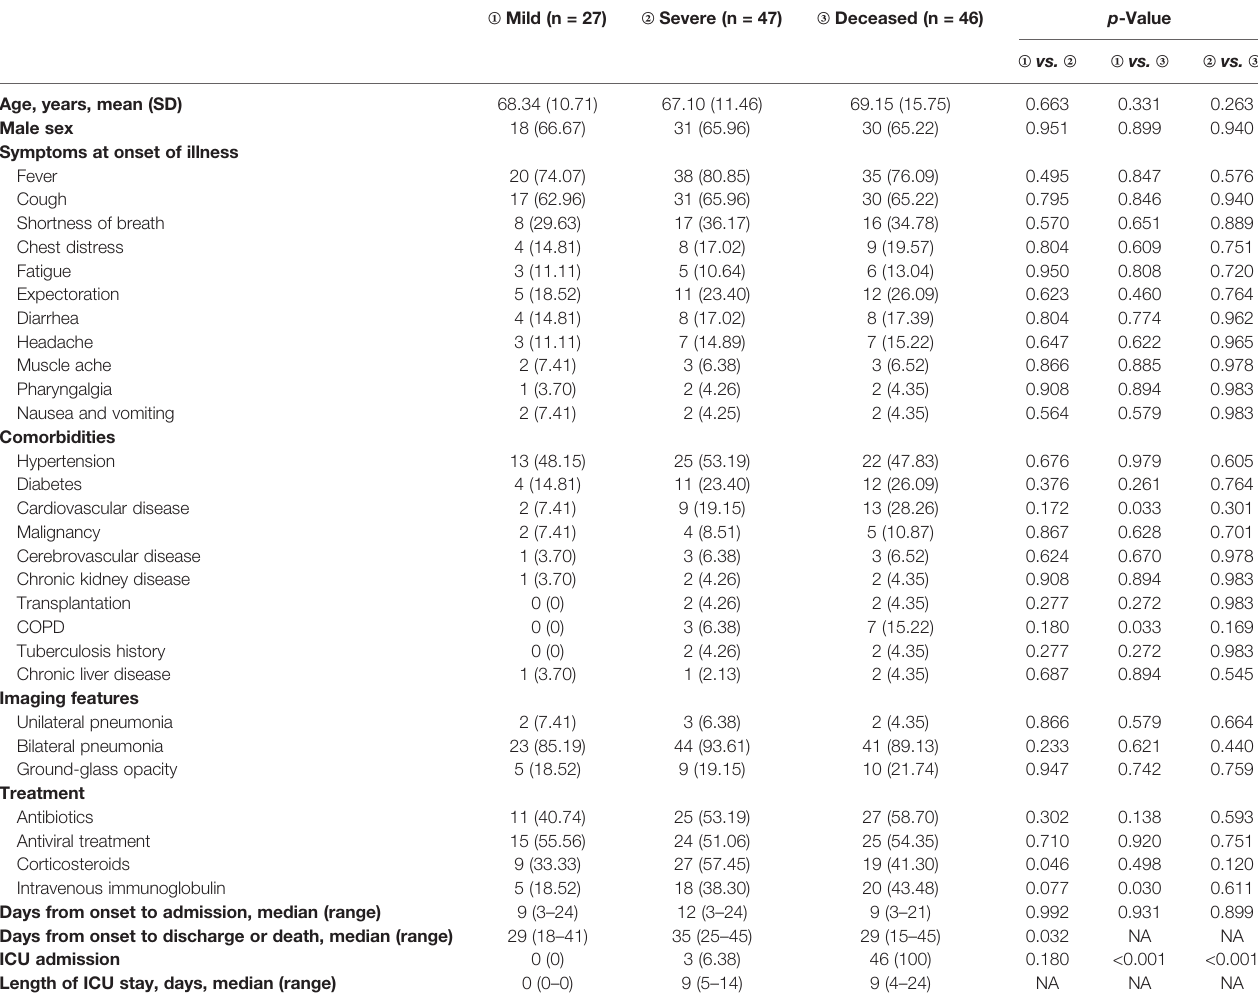
TABLE 1 | The demographic and clinical characteristics of patients with COVID-19.